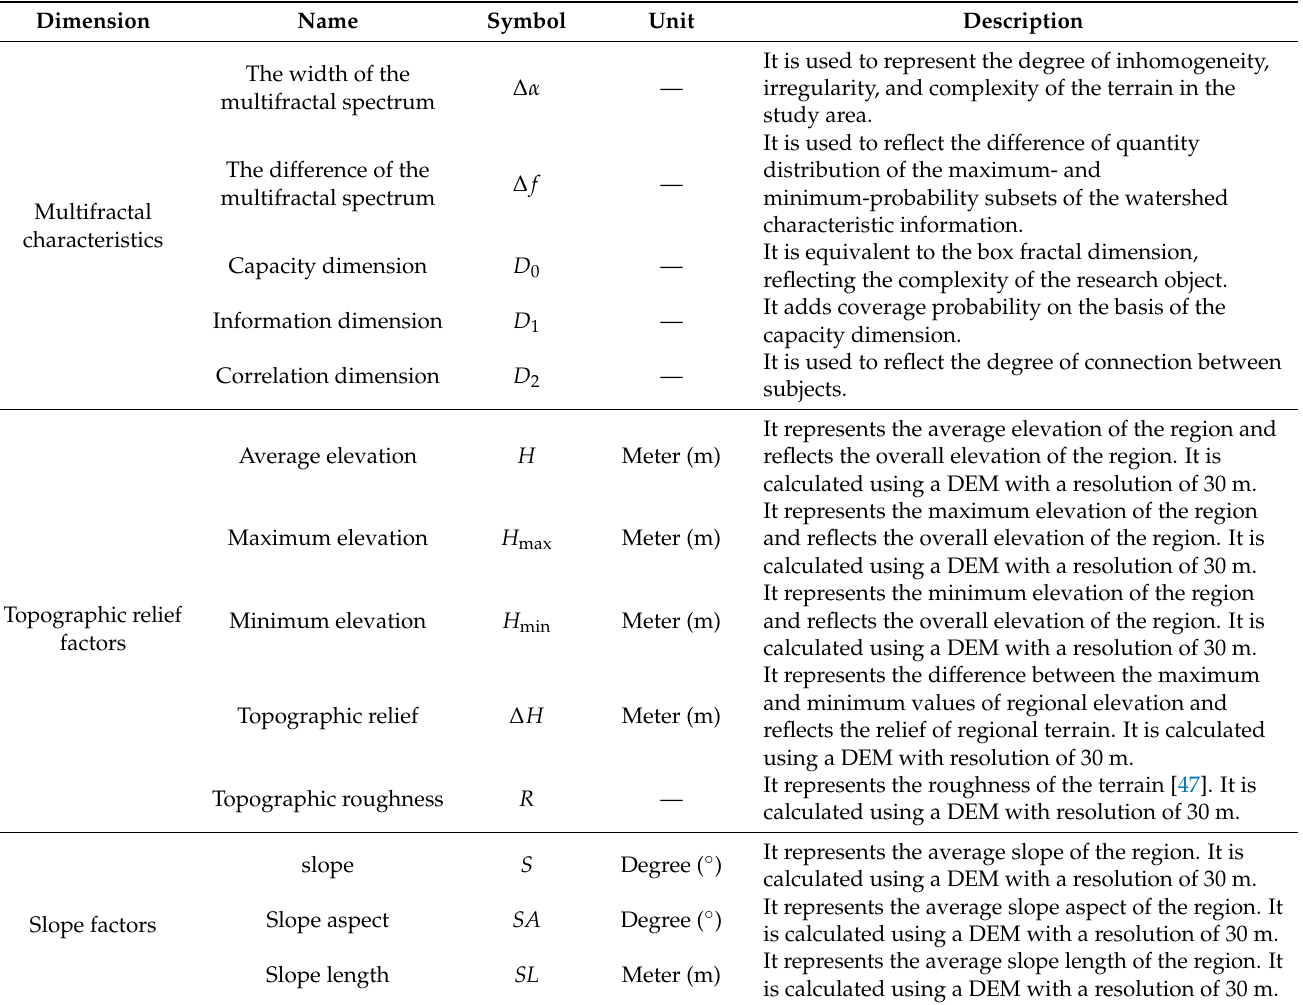
Table 2. Explanatory variables and their